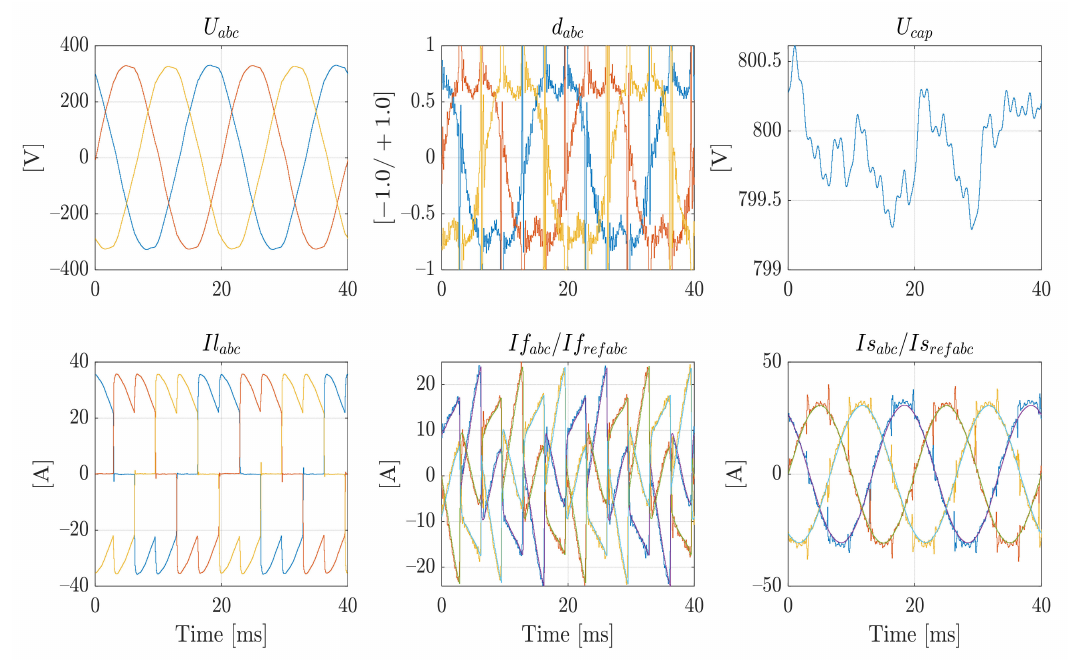
Figure 11. Results of the optimal